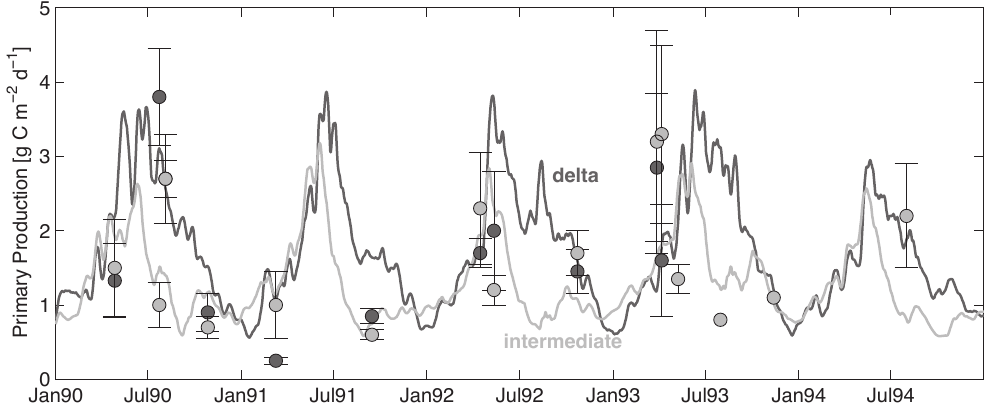
Fig. 10. Simulated primary production averaged for the delta and intermediate regions (solid lines) compared to measurements by Lohrenz et al. (1997) for the same regions (filled circles with errorbars represent mean and standard deviation). The dark and lights gray symbols and lines correspond to the delta and intermediate regions,